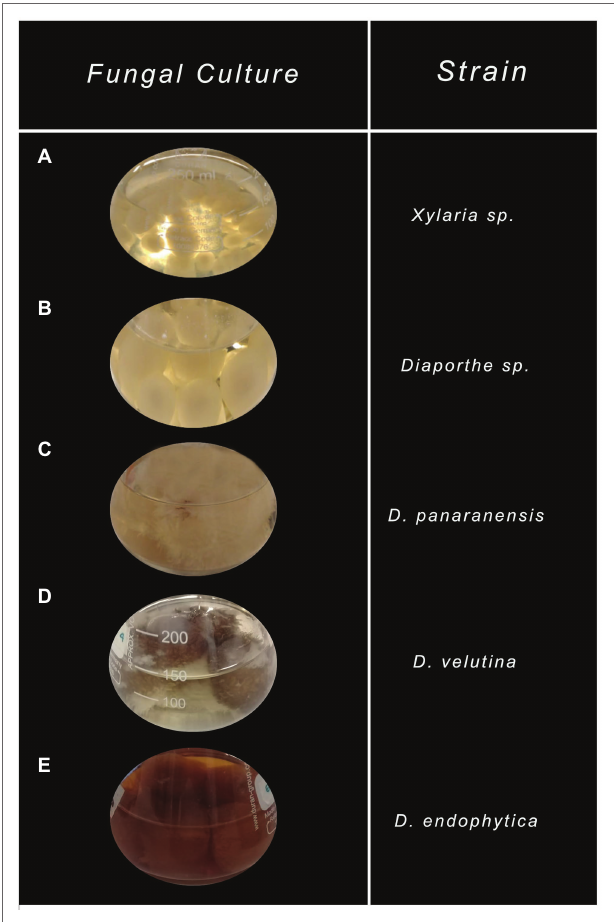
FIGURE 4 | Characteristic of endophytic fungal cultures grown on potato dextrose broth (PDB) after depleting all carbon sources. (A) Xylaria sp., (B) Diaporthe sp., (C) Diaphorte panaranensis ., (D) Diaporthe velutina , and (E) Diaporthe endophytica .